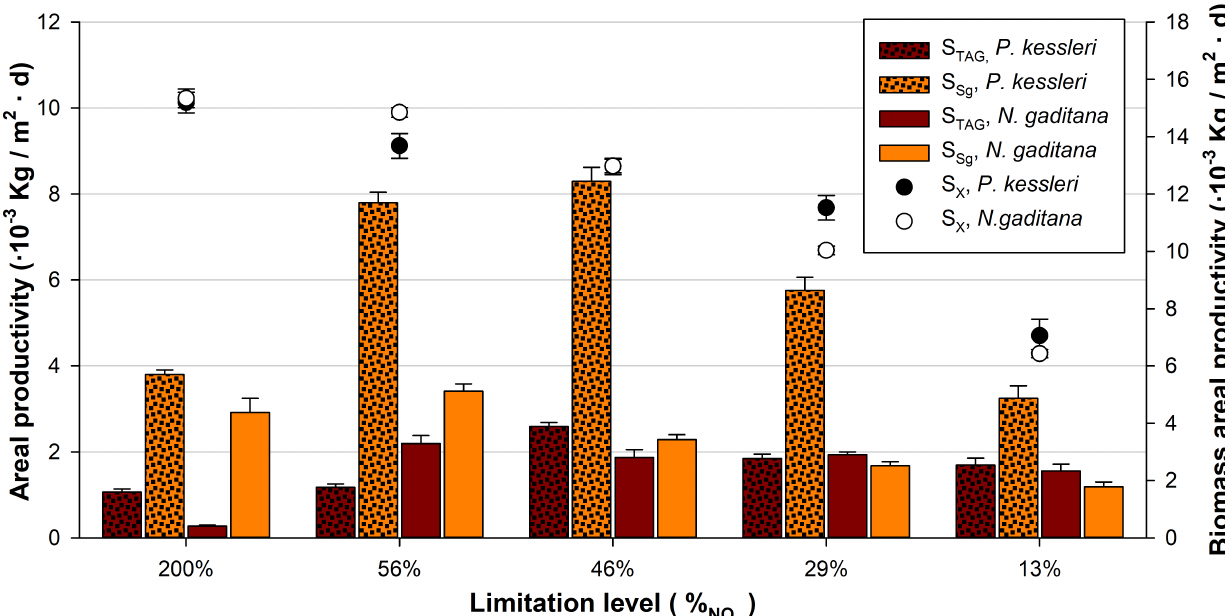
Figure 3. Areal productivities for Biomass ( S X ), TAG ( S TAG ) and carbohydrates ( S Sg ) of N. gaditana and P. kessleri at steady state for several levels of nitrogen limitation. Error bars in N. gaditana are for SE with n = 4, for the rest, refer to Kandilian et al.